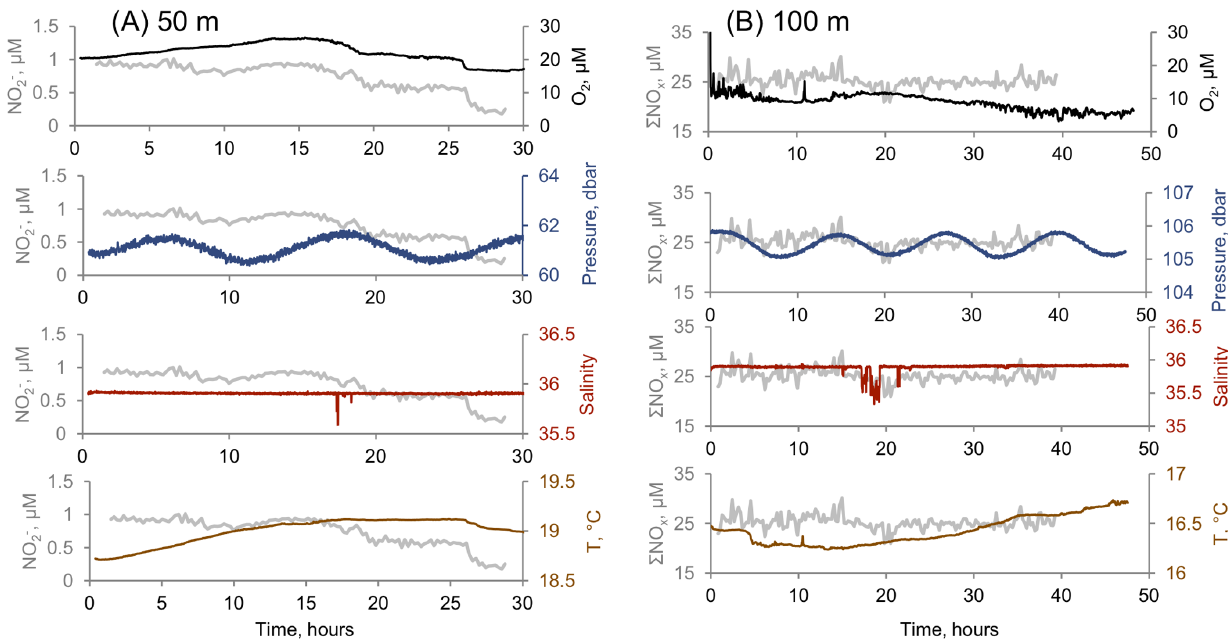
Fig 6. Time-Series of other parameters obtained during the lander deployments. (A) Time series of O 2 , pressure, salinity and temperature (black) plotted with NO 2- series (gray) in the 50 m site. (B) Time series of O 2 , pressure, salinity and temperature (black) plotted with Σ NO x series (gray) in the 100 m